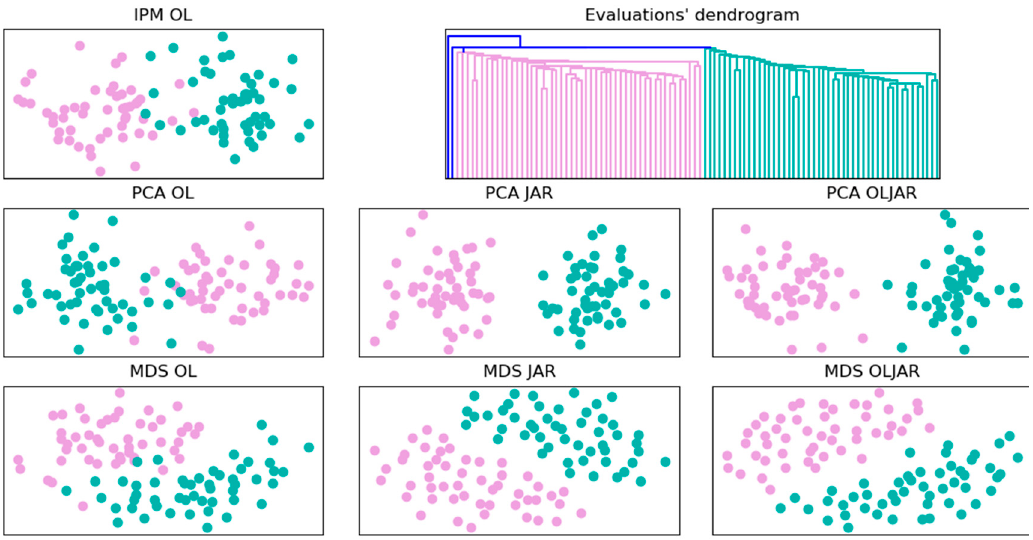
Figure 3. Experiment 1. Consumers’ groups, pink and green points represent women and men consumers, respectively.